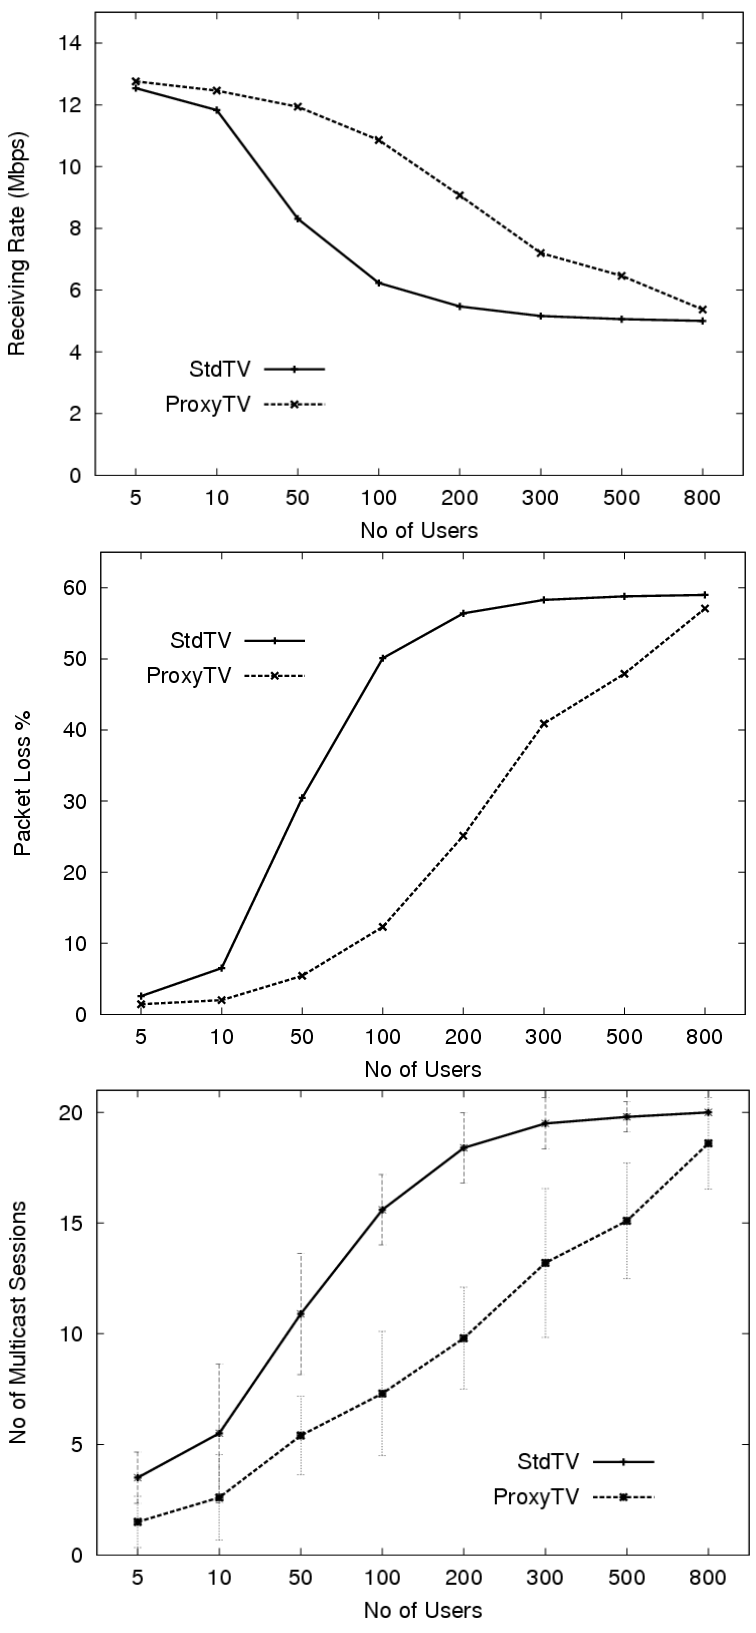
Figure 5. Statistical performances with and without ProxyTV (100 Mbps link bandwidth). a. (top) Receiving rate; b. (middle) Packet loss rate; c. (bottom) Multicast